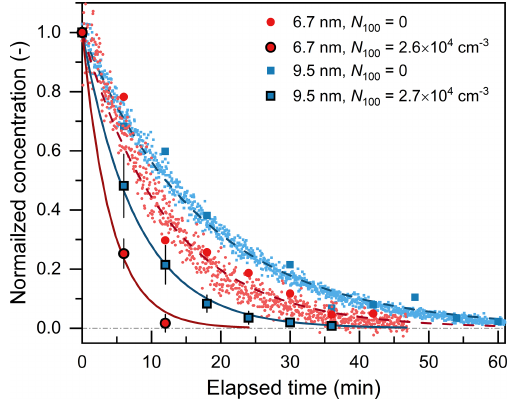
Figure 5. Decay of the concentration of sub-10nm organic parti- cles in the chamber due to wall loss, dilution, and coagulation sink. Sub-10nm particle concentration is normalized by dividing it by the value measured at t = 0. N 100 is the concentration of 100nm particles used to provide the coagulation sink. The small and large markers represent data measured by a CPC and an SMPS, respec- tively. The variation bar indicates the standard deviation of normal- ized sub-10 concentration in repeated experiments.